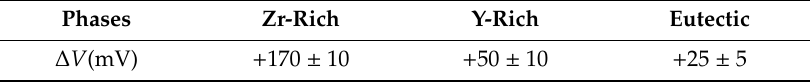
Table 2. Volta potential di ff erences of the phases, data from [38].